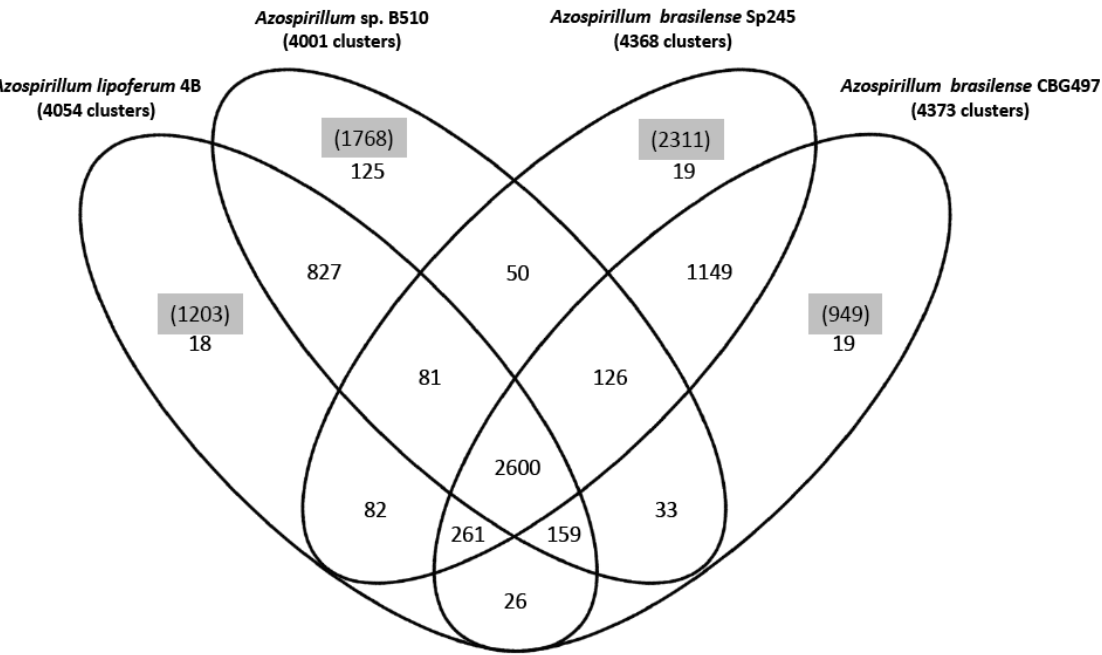
Figure 1. Venn diagram showing the distribution of protein families in the genomes of A. brasilense CBG497, A. brasilense Sp245, A. lipoferum 4B, Azospirillum sp. B510. Numbers in black indicate the number of protein families; numbers in parenthesis and highlighted in grey refer to the number of unique proteins in each genome that do not fall in any family.